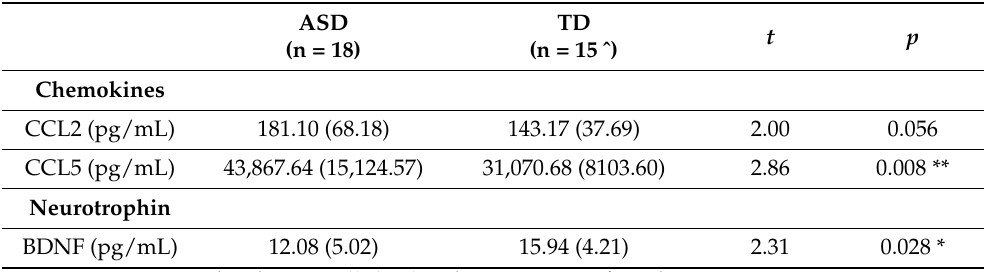
Table 3. Comparison of mean concentrations of chemokines and neurotrophin in children with autism (ASD) and typically developing (TD) controls.